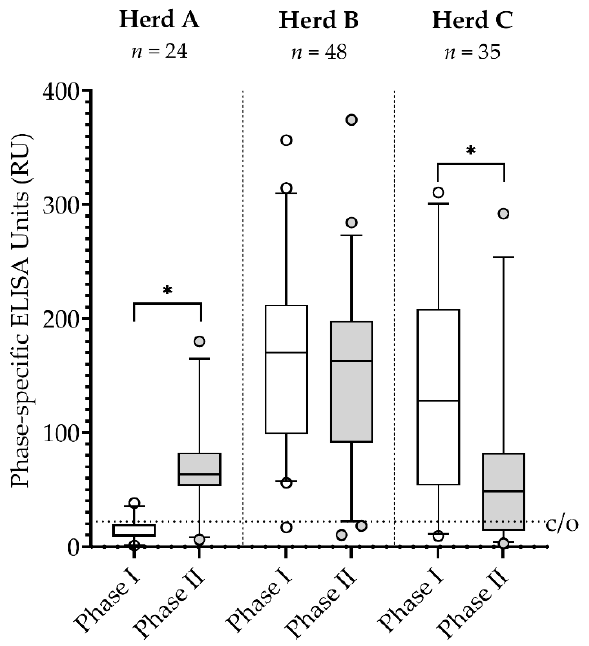
Figure 1. Median levels of IgG phase I and phase II Coxiella burnetii antibodies in three naturally infected dairy goat herds (A–C) at the start of the investigation in 2018. * p < 0.05; c/o = ELISA cut ‐ off.